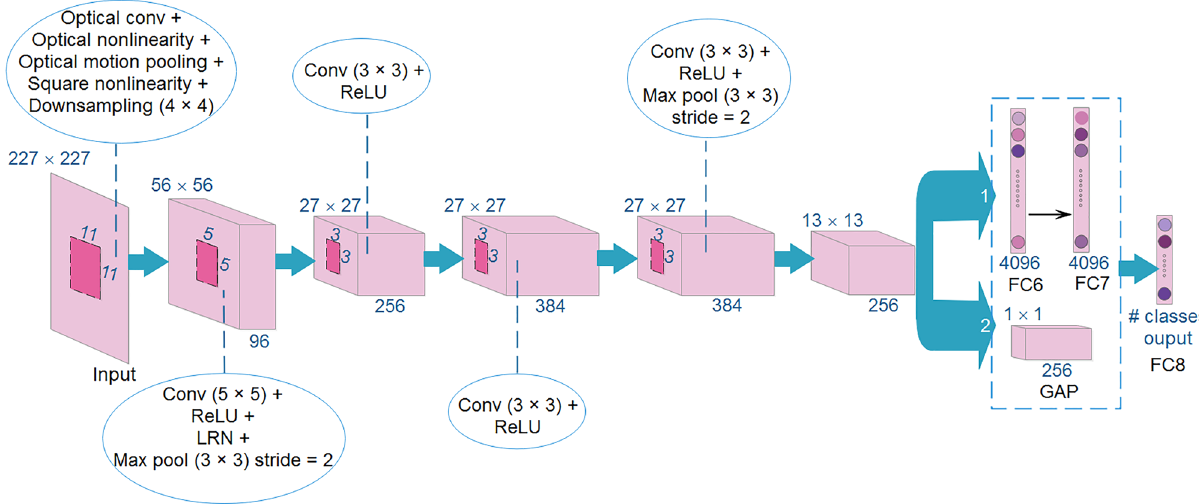
Figure 1. The schematic of Trans-ONN